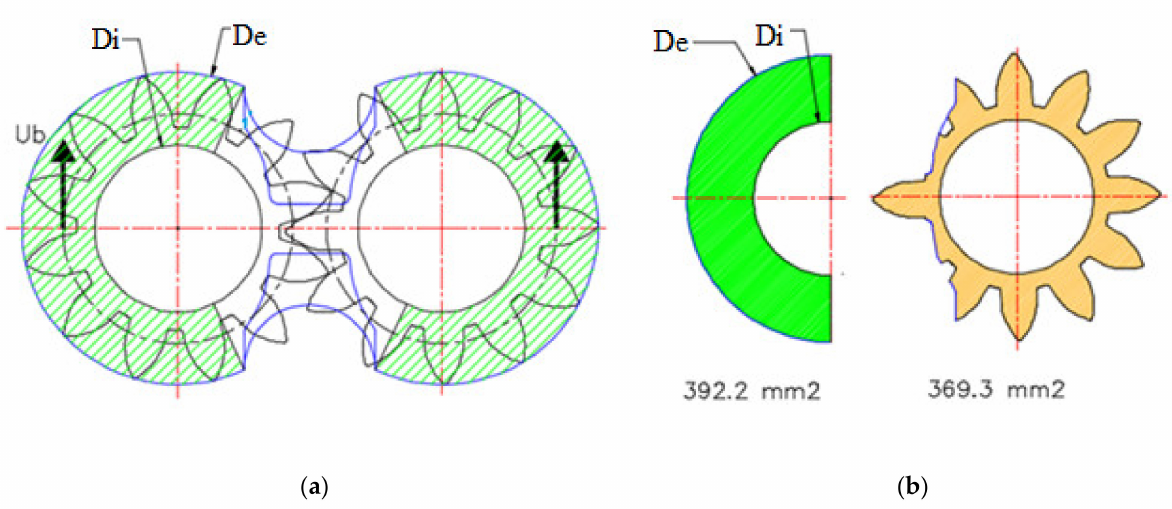
Figure 8. ( a ) Analogy with two fixed-incline slide bearings; ( b ) analogy with two parallel-surface squeeze film